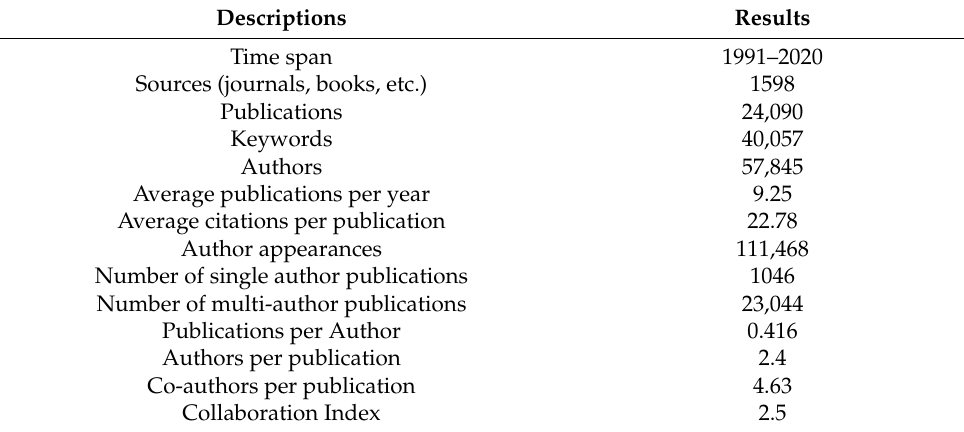
Table 1. Main information regarding the data collection of seed traits